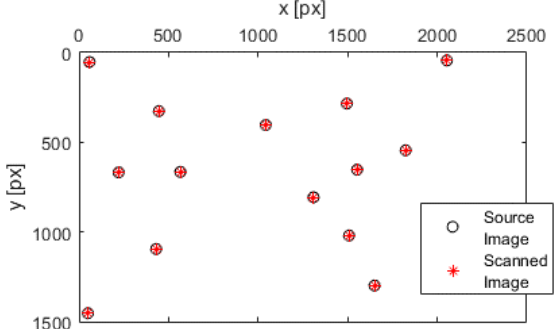
Figure 5. Source and scanned image landmarks (joint space).